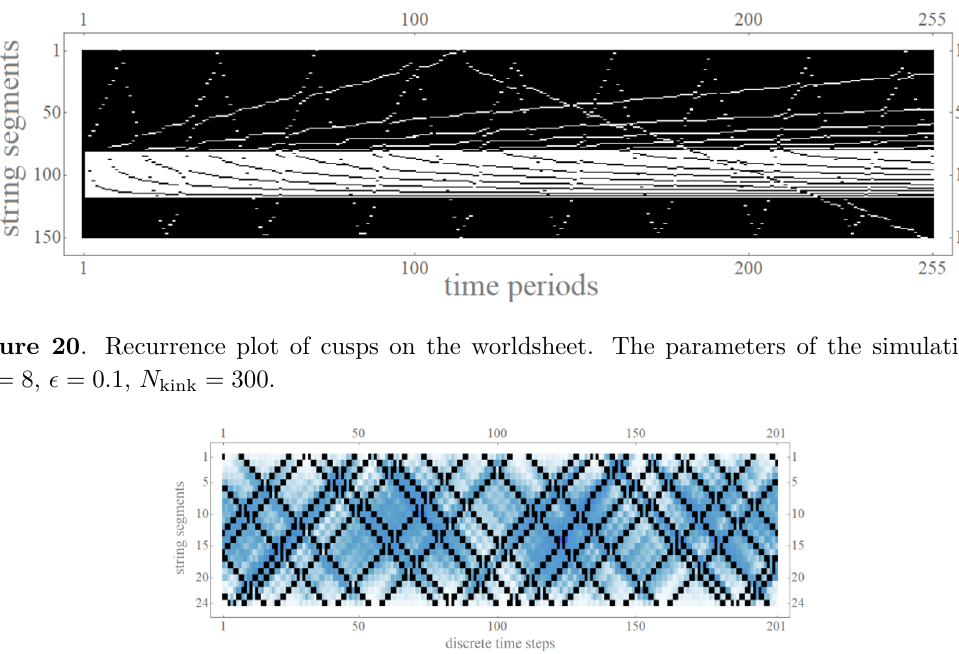
= 50 , after 50000 kink